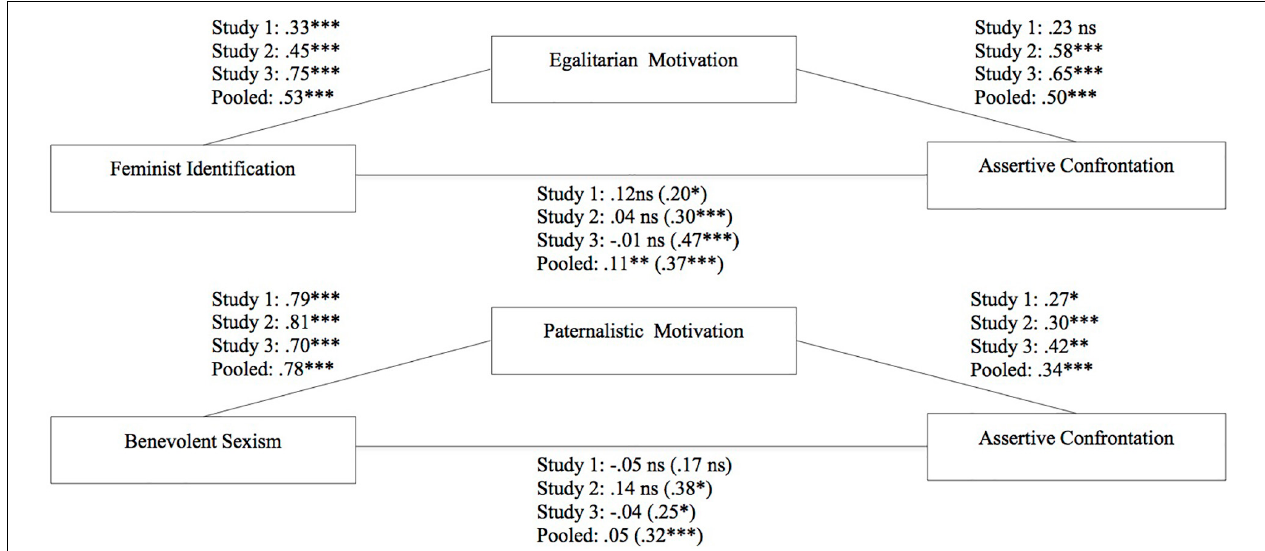
FIGURE 1 | Motivational processes underlying men’s future intensions to confront Studies 1–3 and pooled analysis. Feminist path above and paternalistic path below. ∗ p < 0.05, ∗∗ p < 0.01, ∗∗∗ p < 0.001.